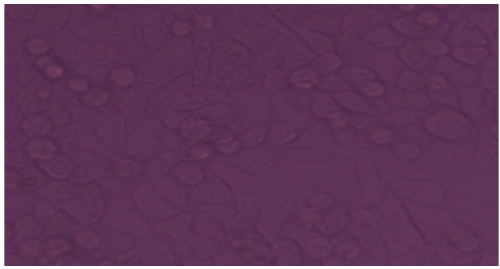
Fig. 1. HEp-2 cell line, control cell line